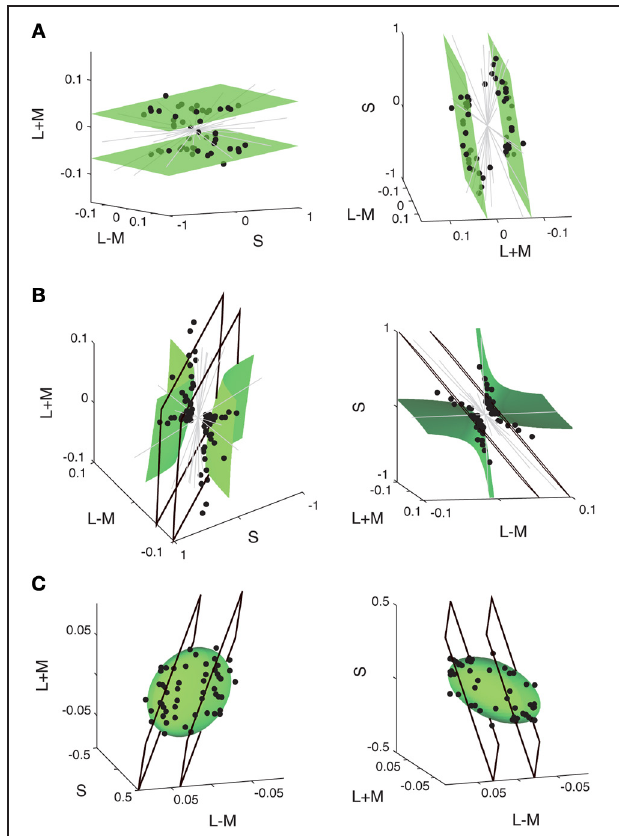
FIGURE 5 | Iso-response measurements of integration of cone signals by neurons in macaque primary visual cortex. The panels show iso-response stimuli (black circles) obtained with drifting chromatic gratings for three representative sample cells in (A) , (B) , and (C) , respectively. Stimuli that yielded the same firing rate are plotted in the space spanned by S-cone activation (S) and by the sum and difference of L-cone and M-cone activation (L + M and L − M, respectively). For each cell, the data are shown in the 3D plots for two different viewpoints (left and right column, respectively). Gray lines indicate directions in stimulus space along which the predefined response criterion could not be reached. As shown by the green surface plots, iso-response stimuli are well fitted by a linear plane for the cell in (A) , by a hyperboloid for the cell in (B) , and by an ellipsoid for the cell in (C) . Panels (B) and (C) also show best fits of linear planes (black quadrangles), which do not provide good descriptions of the iso-response stimuli. Reprinted by permission from Macmillan Publishers Ltd: Nature Neuroscience (Horwitz and Hass, 2012), copyright